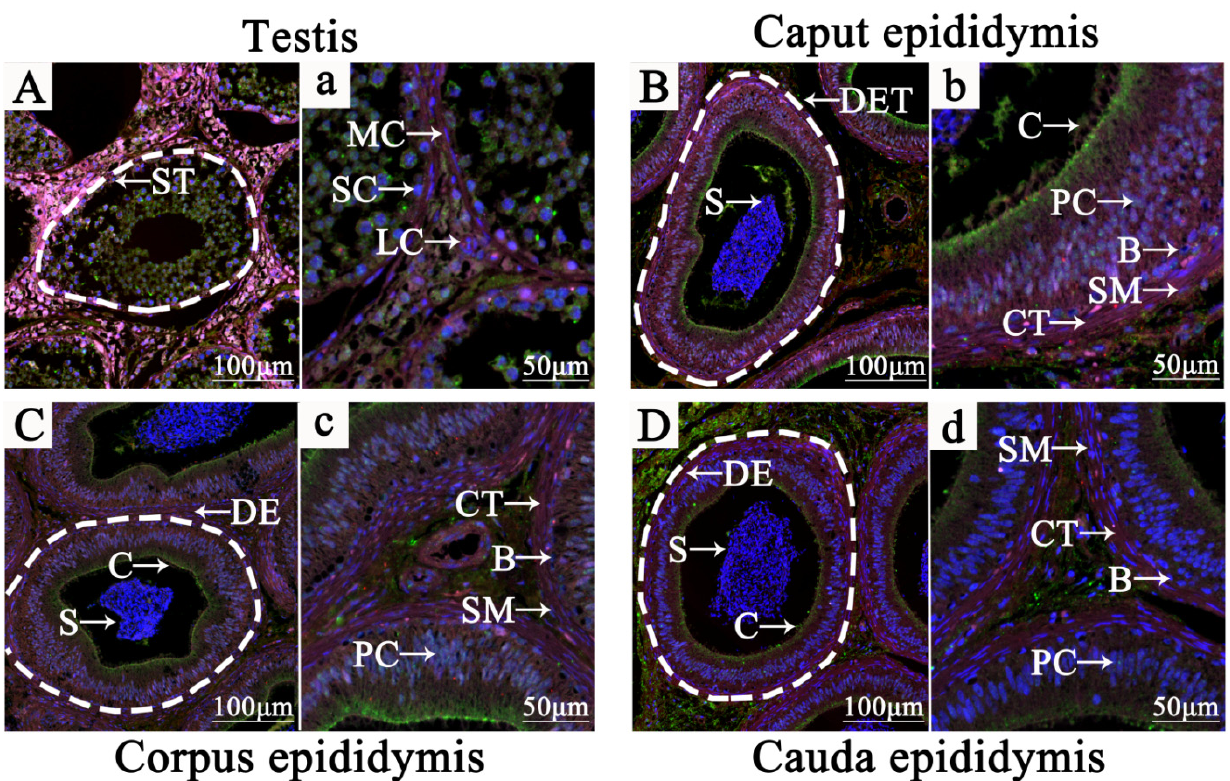
Figure 3. Localization of NR1D1 and NR4A2 in adult yak (4 years old) testis and epididymis tissues using IF staining. ( A – D ), localization of NR1D1 and NR4A2 in adult yak testis, caput epididymis, corpus epididymis and cauda epididymis, respectively (100 × ). ( a – d ), The amplification results of local structures in yak testis, caput epididymis, corpus epididymis and cauda epididymis, respectively (400 × ). ST, seminiferous tubule; MC, myoid cells; LC, interstitial cells; SC, spermatogonium; S, spermatozoon; DET, ductuli efferentes testis; B, basal cells; PC, principal cells; SM, smooth muscle cells; CT, connective tissue; DE, ductus epididymidis.